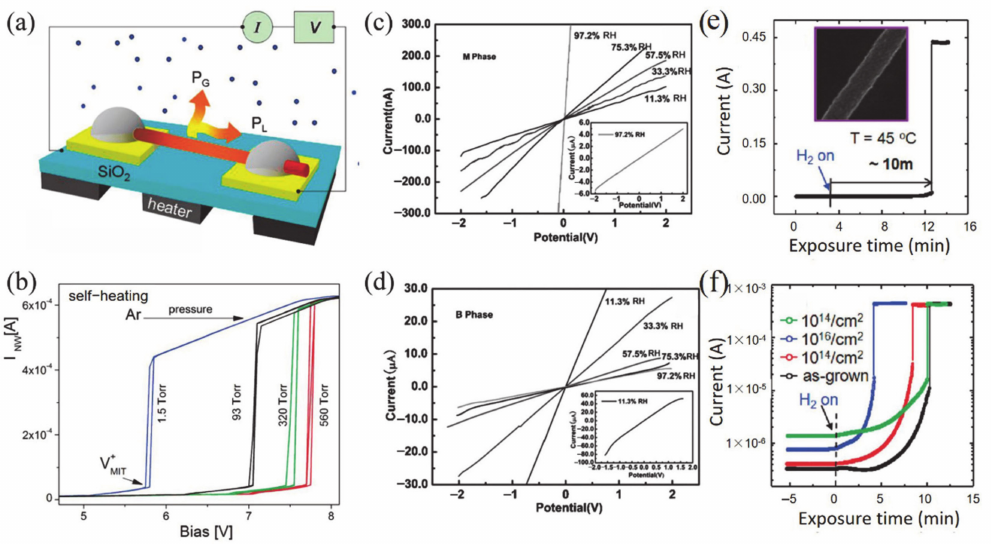
Figure 25. ( a ) The design and principle of operation of a VO 2 NW gas sensor. ( b ) I–V curve of a VO 2 NW at different Ar pressures. Reproduced from [13], with permission from American Chemical Society, 2009. ( c , d ) VO 2 (M) and VO 2 (B) nanoflowers measured in different static atmospheres, respectively. Reproduced from [178], with permission from John Wiley and Sons, 2011. ( e ) Curve of current change and hydrogen exposure time of Pd-decorated VO 2 NW at bias voltage of 10 V. ( f ) Curve of current change with the e-beam irradiation dose and energy (0.5 MeV, red and blue curves; 0.7 MeV, green curve). Reproduced from [179], with permission from American Chemical Society,